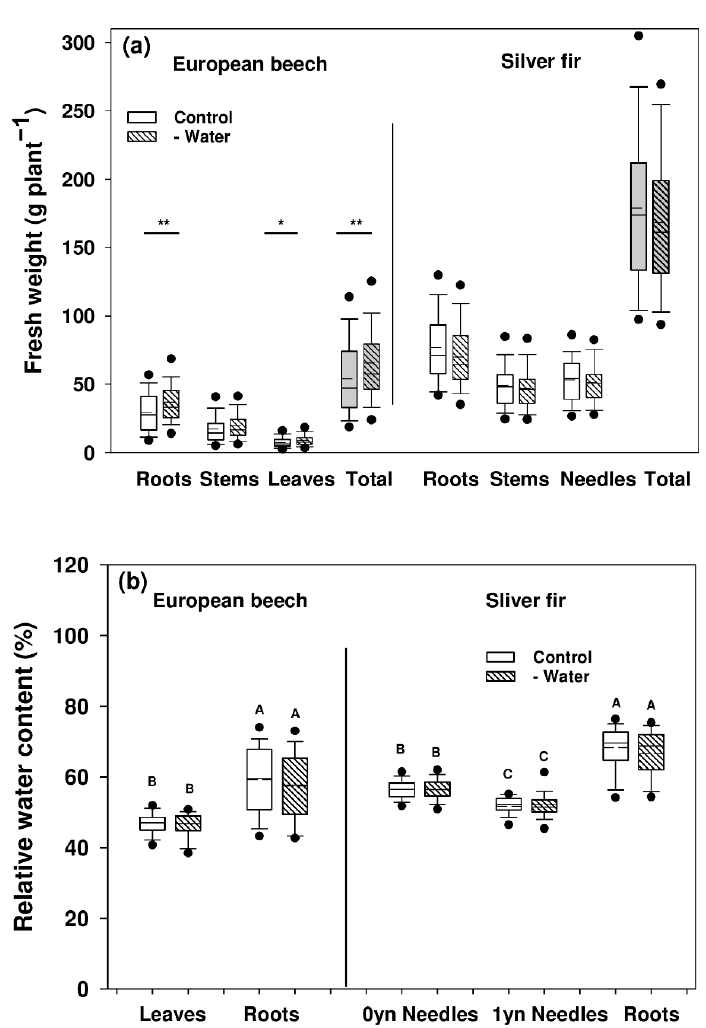
Figure 1. Fresh weight ( a ) and relative water content ( b ) of European beech and silver fir seedling after two years of growth in mixed cultivation regardless of the number of inter-species neighbors. -Water: Beech/fir mixtures exposed water deprivation and rewatering during the first year of growth. Data shown are means ± SD (beech: n = 75–80, fir: n = 74–80). Significant differences of fresh weight between control and -Water are indicated by asterisks (*, p < 0.05; **, p < 0.01), significant differences ( p < 0.05) of relative water content between control and -Water are indicated by different capital letters.